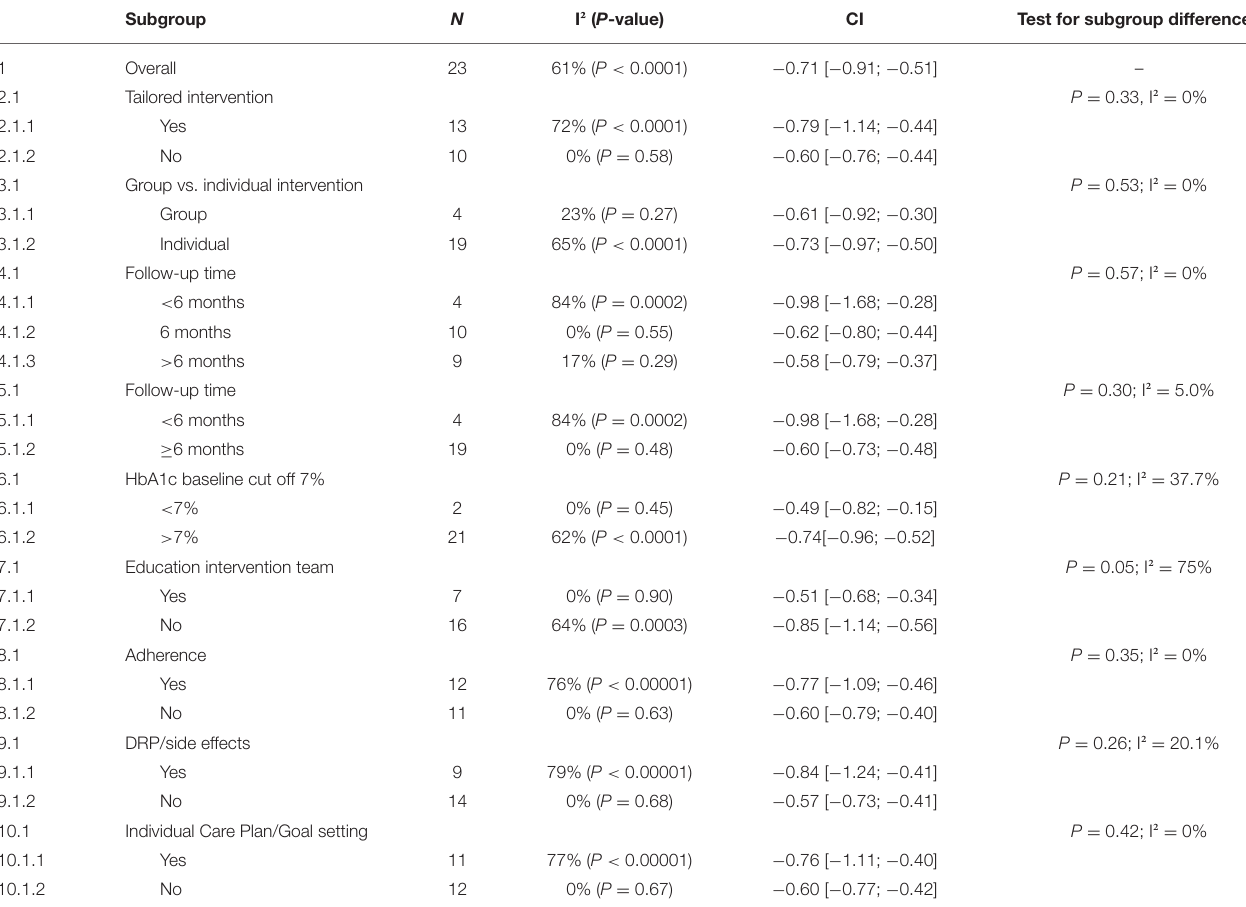
TABLE 3 | Subgroup analyses